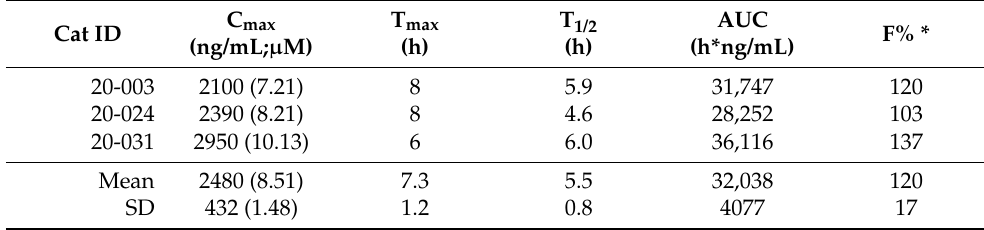
Table 5. Pharmacokinetic parameters for GS-441524 after a single IV dose of RDV (7 mg/kg) in 3 Table 4. Pharmacokinetic parameters for GS-441524 after a single oral dose of RDV (25 mg/kg) in 3 cats. cats.